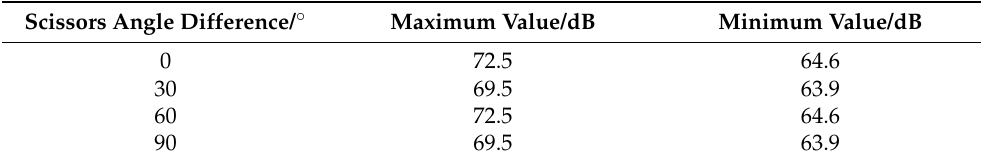
Table 9. Maximum and minimum SPL values at an azimuth angle = 90 ◦ in fixed-wing mode. Scissors Angle Difference/ ◦